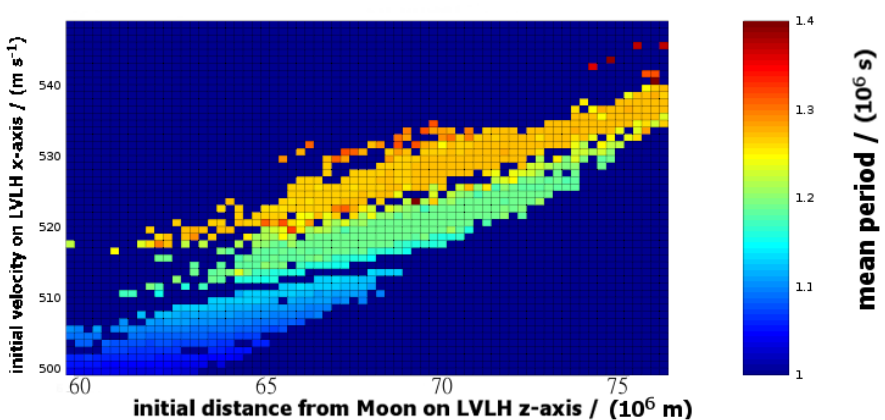
Figure 24. Detailed view of the mean orbital period for the same initial conditions as Figure 22. The color-axis shows the period in